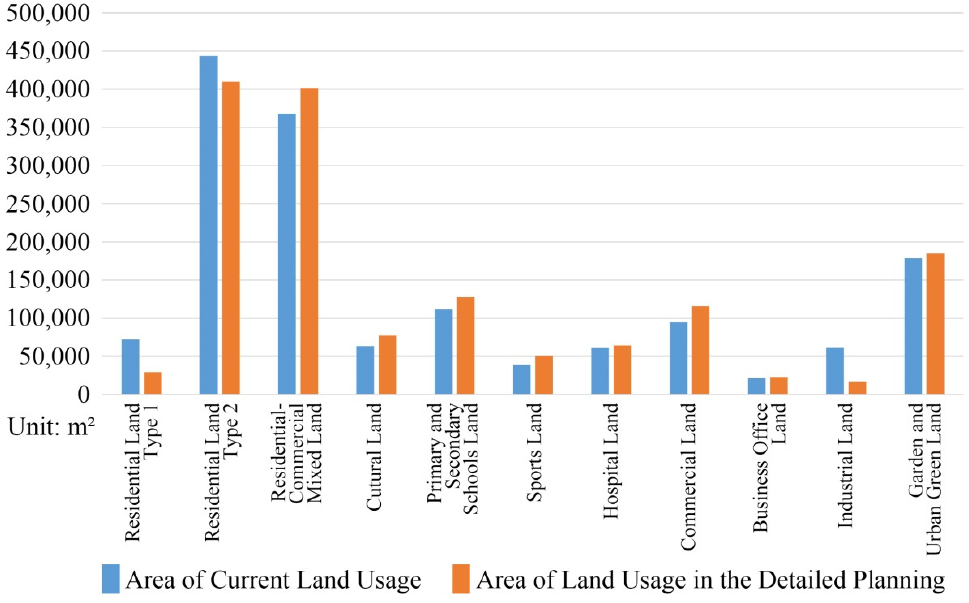
Figure 20. Comparison of the Area of Current Land Usage and That in the Detailed Planning.